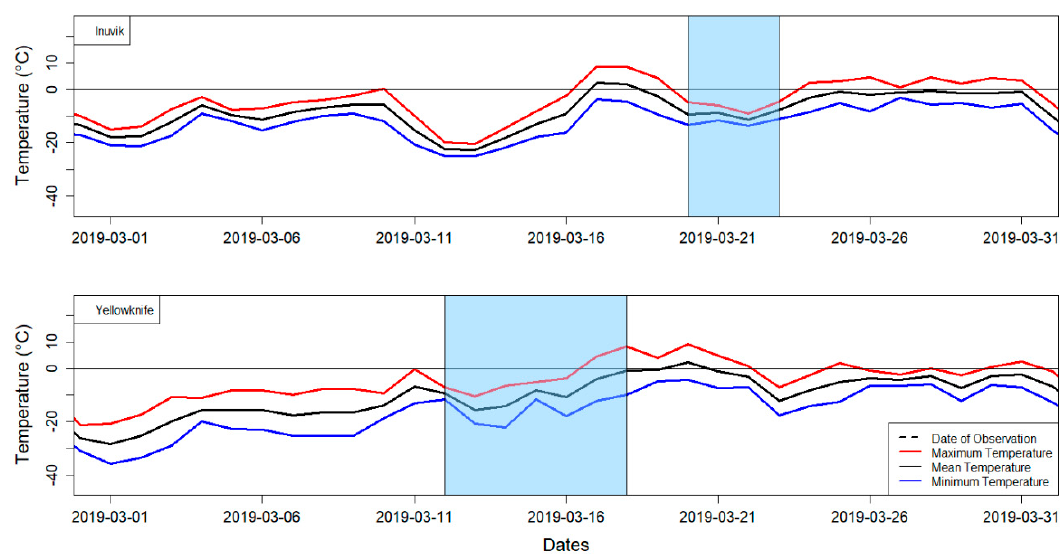
Figure 7. Maximum, minimum, and mean air temperatures recorded at Inuvik (top panel) and Yellowknife (bottom panel) during the 1 January–31 May 2019 period. Shaded boxes correspond to field measurement periods when GPS data and ice thickness measurements were collected.